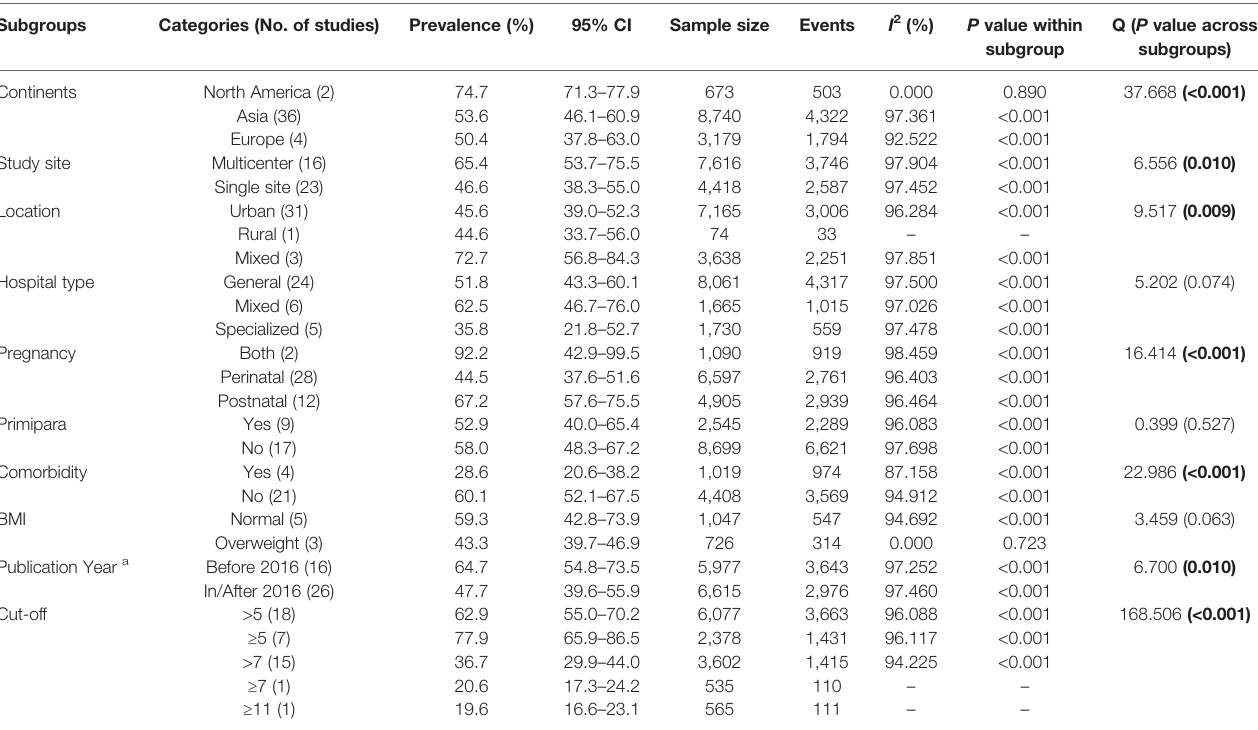
TABLE 3 | Subgroup analyses of prevalence of poor sleep quality. Subgroups Categories (No. of studies) Prevalence (%)